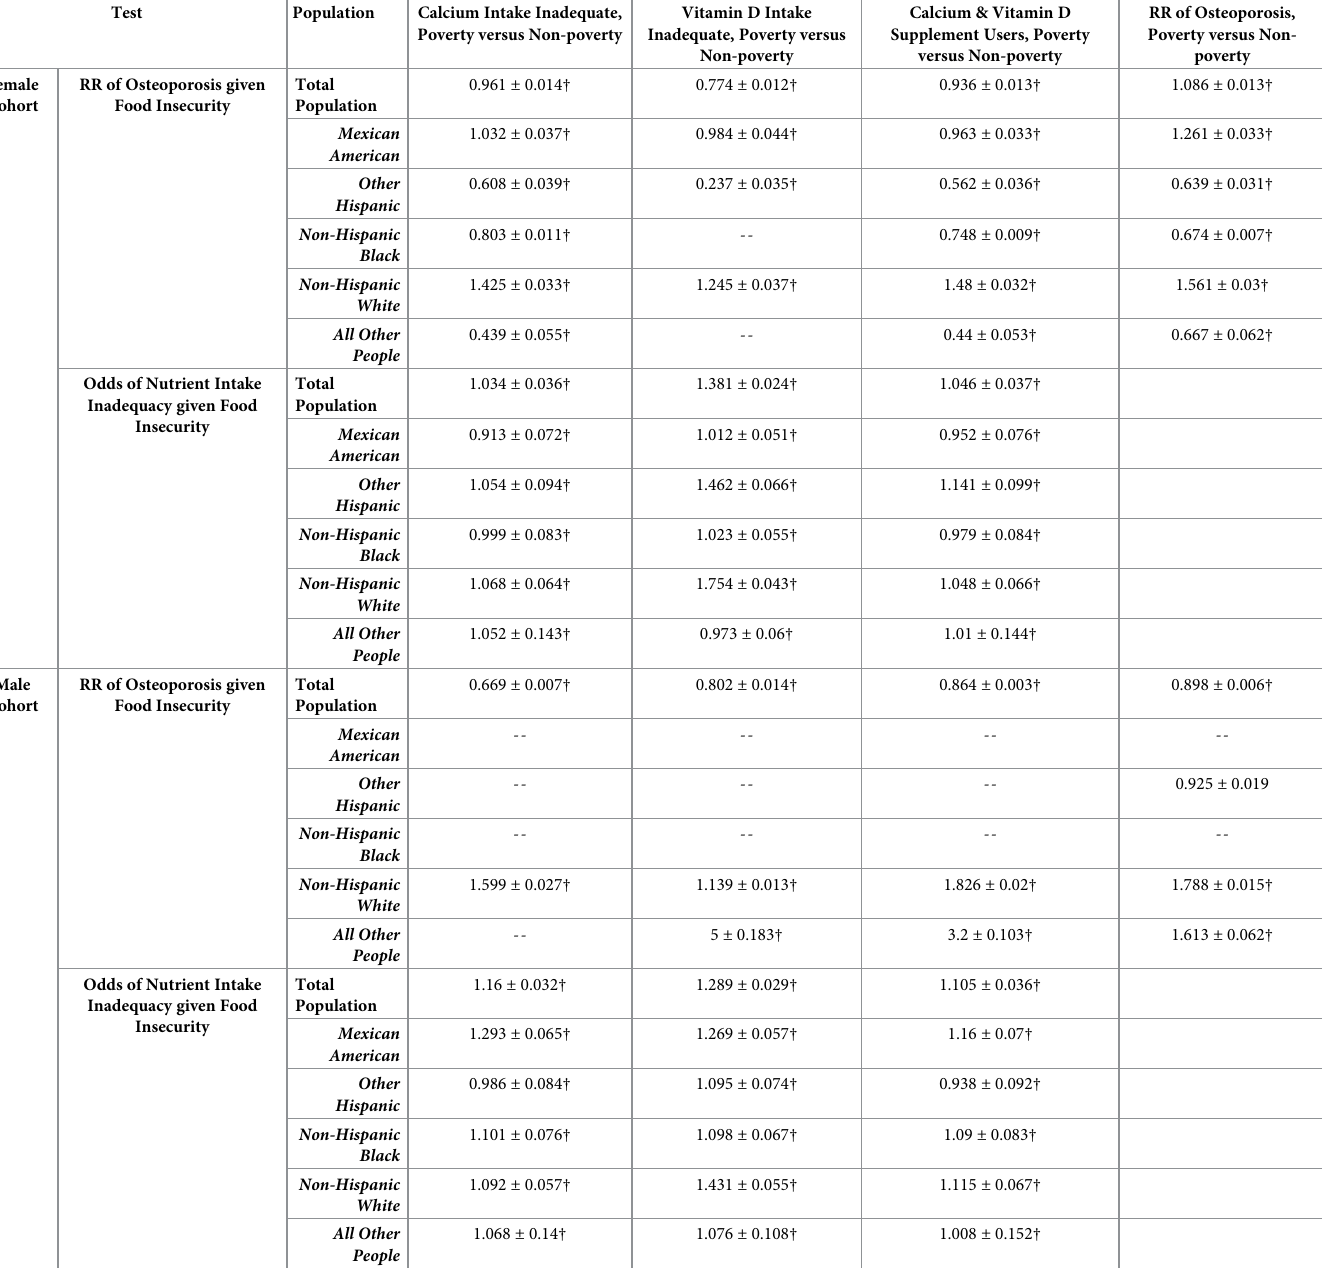
Table 5. Influence of food security status on RR of nutrient intake & osteoporosis with analysis by ethnicity and gender, age 50 and